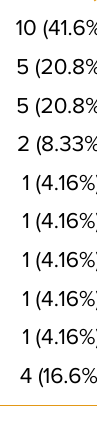
Table 3. Immunomulatory therapy before starting the infliximab therapy in patients with HLA-B27 ocular inflammation Immunomodulatory therapy